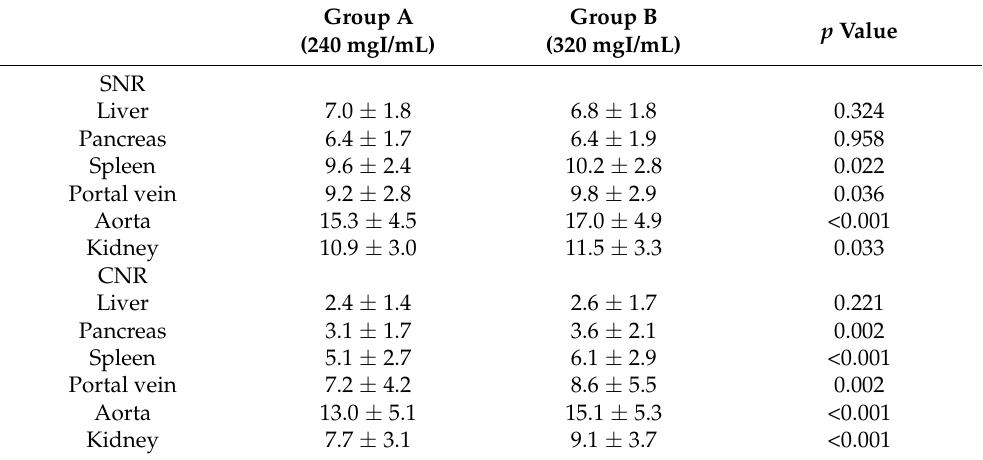
Table 3. Quantitative image analysis in both groups according to the concentration of contrast material.